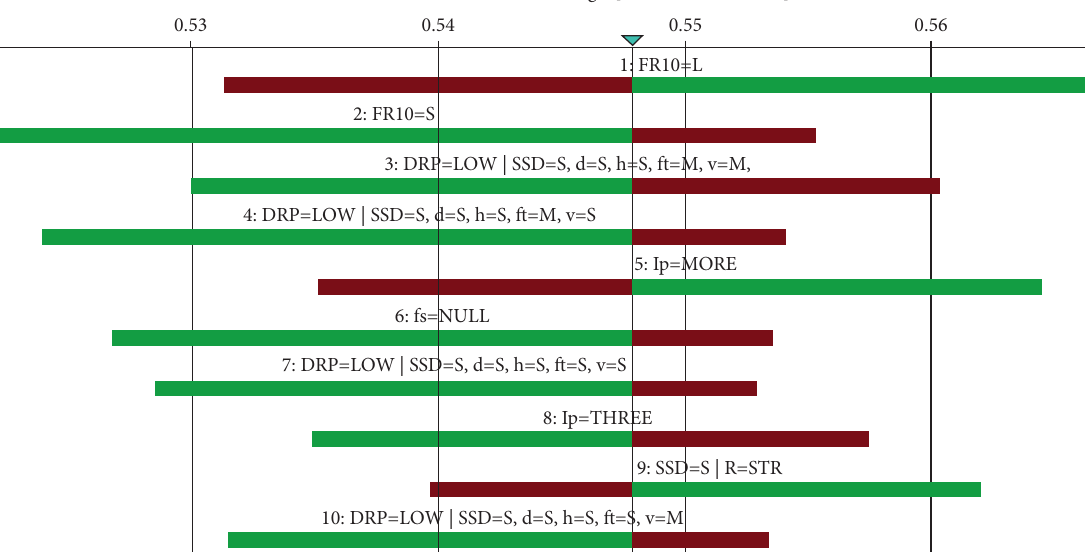
Figure 7: Sensitivity analysis of DRP (DRP � HIGH).